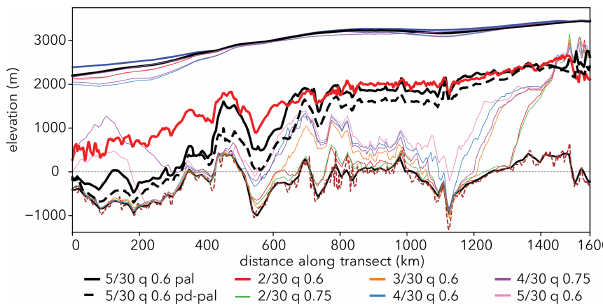
Figure 11. Simulated and observed isochrone elevations along transect CEA-10. The thick red line depicts the observed 90ka radar reflector, the black line the 220ka palaeo-simulation with a palaeo-precipitation–temperature relationship of 5%K − 1 . The dashed black line shows the isochrone elevation computed with the respective present-day time slice (pd-pal case) of the palaeo- simulation (pal). The thin coloured lines represent the simulated isochrone and surface elevation from the present-day equilibrium ensemble (pd). Bedrock elevation in the pal model run is plotted in black and bedrock elevation derived from Morlighem et al. (2020) in red. The observed surface elevation is plotted in dark